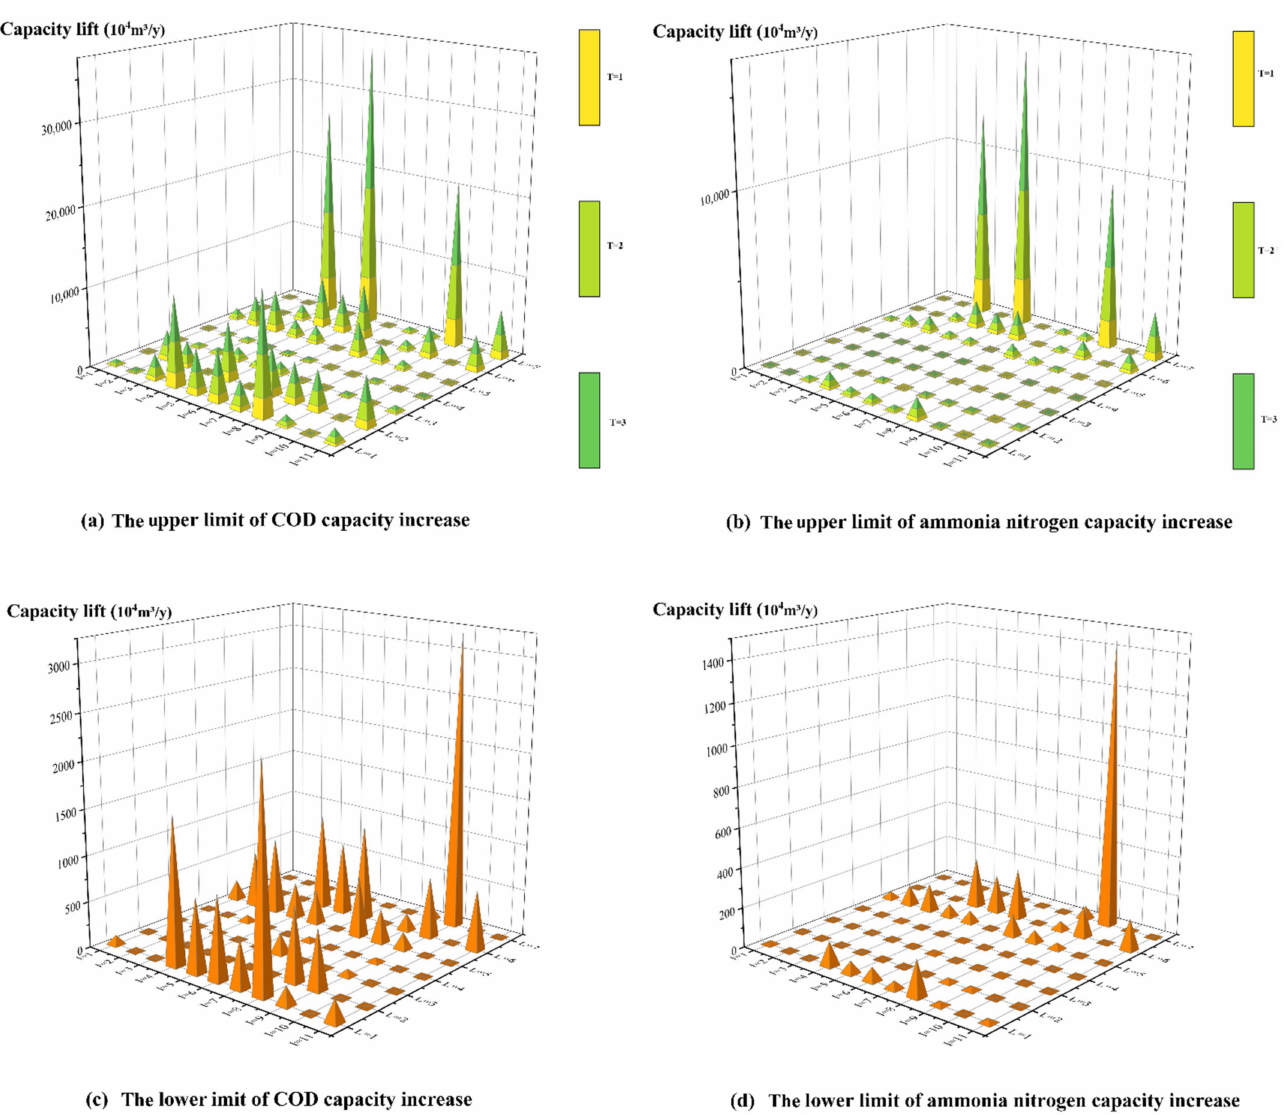
Figure 4. COD and ammonia nitrogen capacity increase at each control section in the Yinma River Basin.( a ) The upper limit of COD capacity increase at each control section in the Yinma River Basin ( b ) The upper limit of ammonia nitrogen capacity increase at each control section in the Yinma River Basin ( c ) The lower limit of COD capacity increase at each control section in the Yinma River Basin ( d ) The lower limit of ammonia nitrogen capacity increase at each control section in the Yinma River